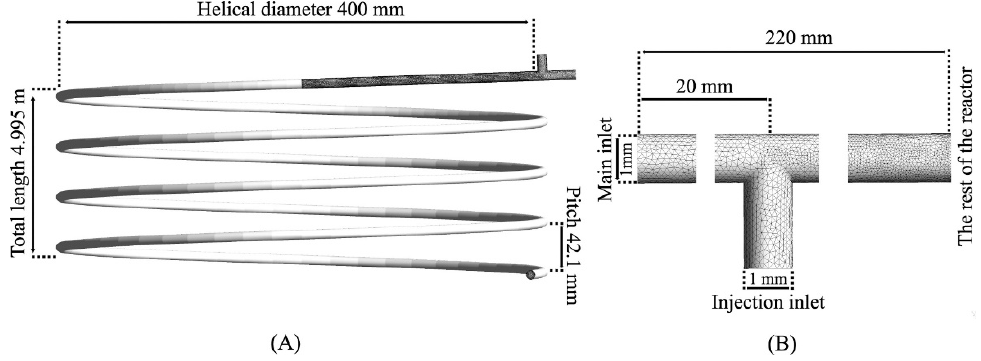
Figure 4. Scheme of the helical reactor ( A ) and the injector tube ( B ) [72]. Reprint with permission from ref. [72]. Copyright 2018 Elsevier.